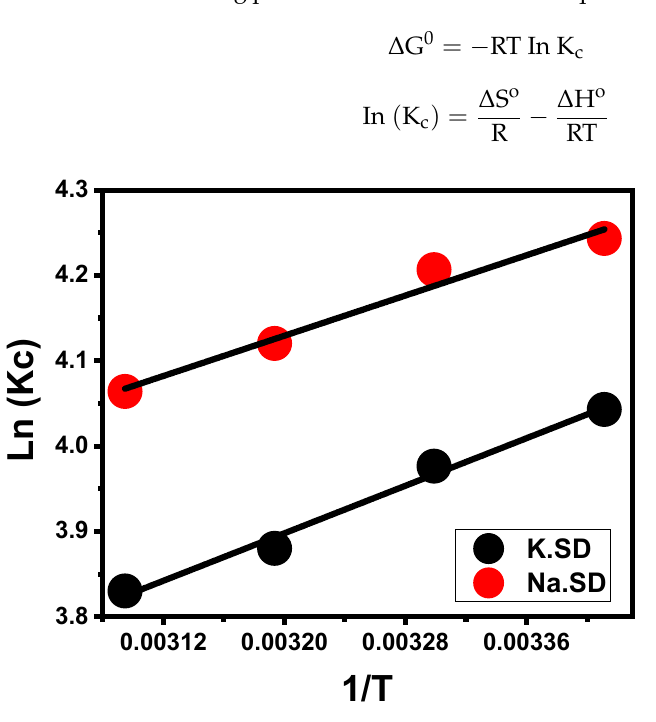
Figure 8. Fitting of the PO 43 − sequestration results with Van’t Hoff equation (pH 6, 100 mg L − 1 phosphate concentration, 0.1 g L − 1 dosage, and 960 min adsorption duration).